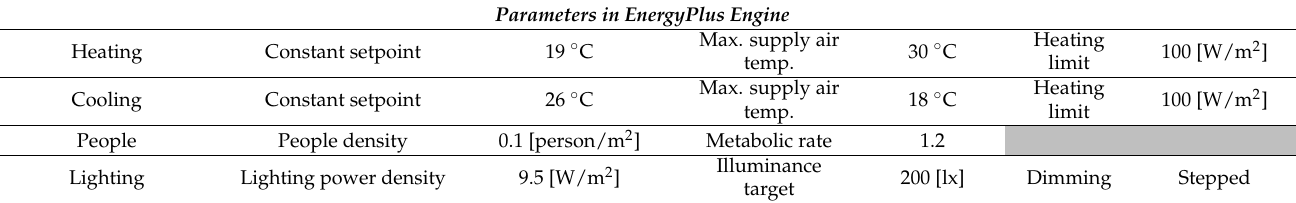
Table 1. Cont. Parameters in EnergyPlus